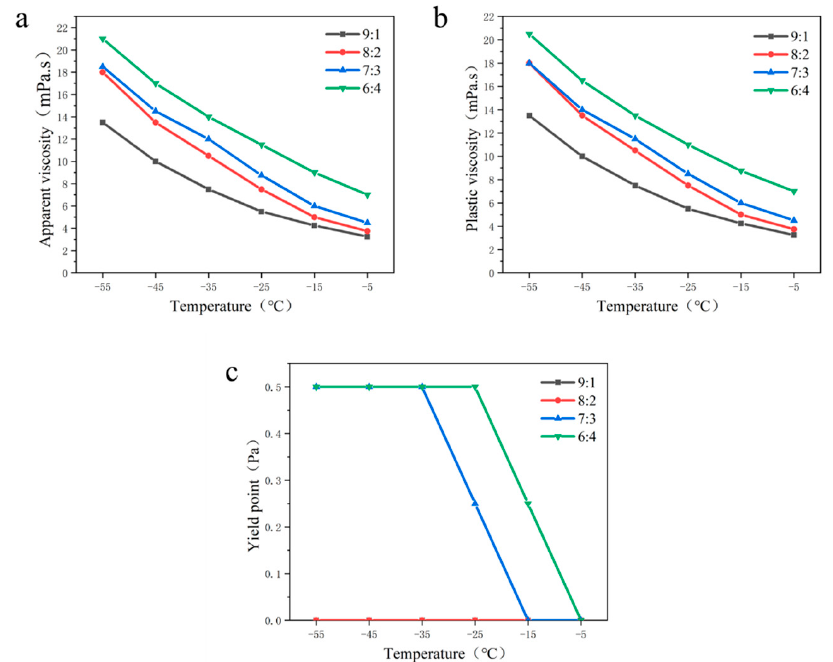
Figure 4. Influence of the base fluid ratio on the rheological properties of the drilling fluid; ( a ) apparent viscosity; ( b ) plastic viscosity; ( c ) yield point.